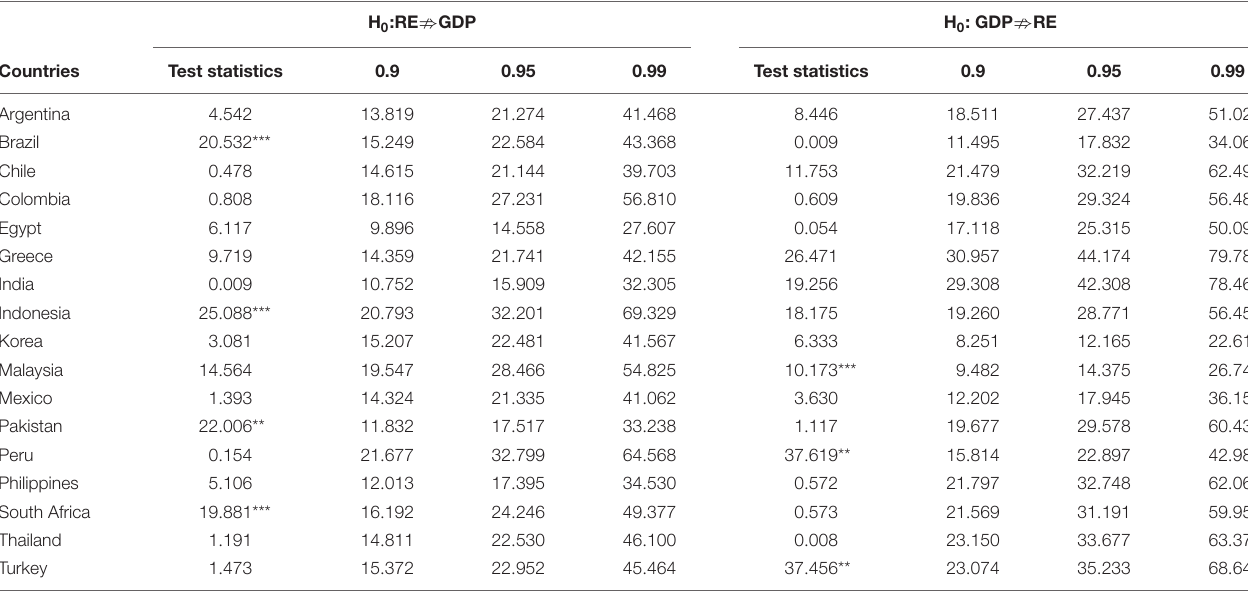
TABLE 3 | Bootstrap panel causality test results for